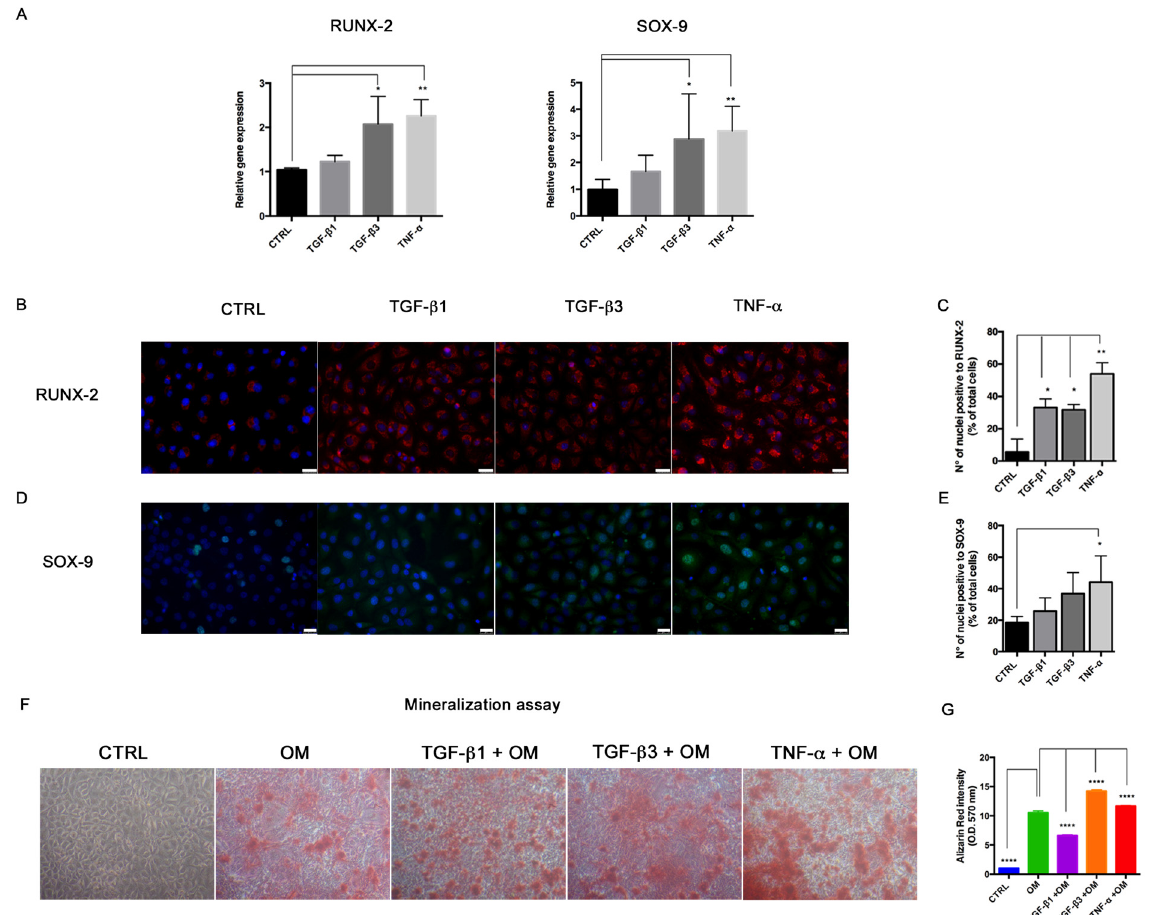
Figure 5. End–MT stimulates the origin of osteogenic progenitors. ( A ) Transcriptional levels of RUNX-2 and SOX-9, analyzed by Real-Time PCR in HUVECs exposed for 6 days to TGF- β 1, TGF- β 3 and TNF- α . Results are reported as fold changes relative to the untreated controls. Data are expressed as mean ± SD of at least 3 independent experiments, and statistical analysis was performed by unpaired Student’s t test. * p < 0.005; ** p < 0.001; **** p < 0.0001. Immunofluorescence and relative quantification of ( B , C ) RUNX-2 (red spots within nuclei) and ( D , E ) SOX-9 (green nuclei) in HUVECs exposed to TGF- β 1, TGF- β 3 and TNF- α for 6 days. Scale bars = 25 μ m. ( F ) Alizarin Red stain performed in HUVECs exposed to TGF- β 1, TGF- β 3 and TNF- α for 14 days in presence of osteogenic medium (OM). ( G ) Quantification of calcium-bound Alizarin Red by absorbance measured at O.D. 570 nm by spectrophotometer. Data are expressed as mean ± SD of at least 3 independent experiments, and statistical analysis was performed with respect to HUVECs induced with osteogenic medium (OM) by ordinary one-way ANOVA followed by Dunnett’s multiple comparison test; * p < 0.005; ** p < 0.001; **** p < 0.0001. RUNX-2, runt-related transcription factor -2; SOX-9, SRY box transcription factor-9.